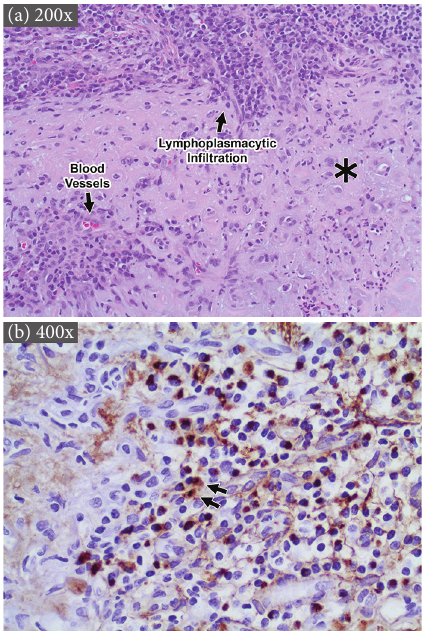
Figure 2: Histology of auricular cartilage, and immunohisto- chemical staining for IgG4 plasma cells from second patient with RP at our institute. (a) High-power magnification of auricular cartilage showing damage to cartilage including cartilage eosino- philia, infiltration by small blood vessels, as well as lympho- plasmacytic infiltration. The asterisk indicates cartilage eosinophilia, and arrows indicate representative small blood vessels and area of lymphoplasmacytic infiltration (H&E, 200x). (b) High- power magnification showing presence of IgG4-positive plasma cells (brown staining) in auricular cartilage, with arrows indicating representative IgG4-positive plasma cells (immunohistochemical staining of IgG4-positive plasma cells, 400x). There were 216 IgG4+plasma cells and 601 IgG+plasma cells, and the IgG4/IgG ratio was